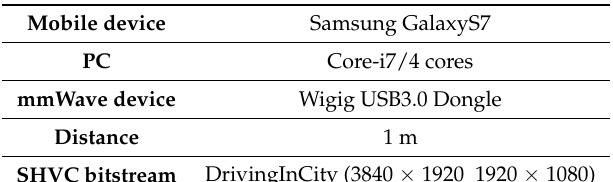
Table 9. Setting parameters for PC offloading